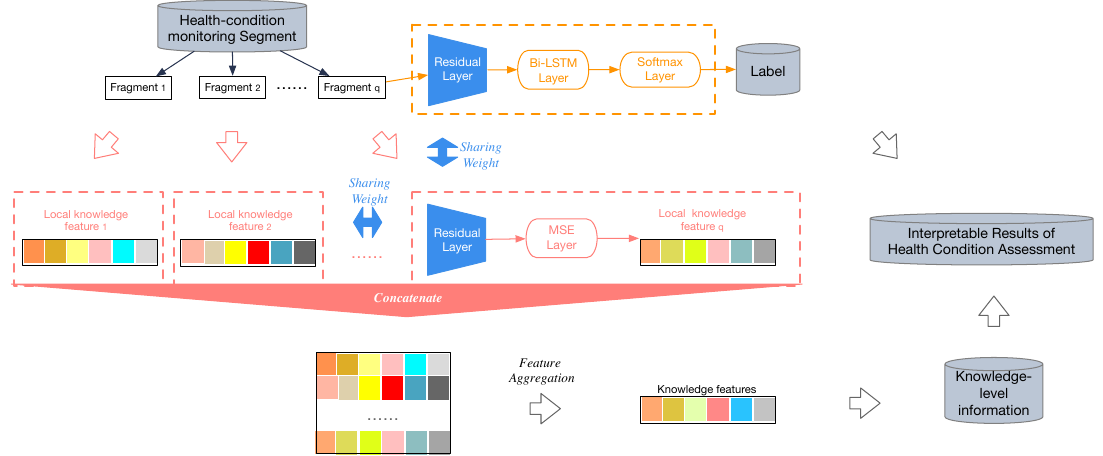
Figure 5. The architecture of a knowledge-directed interpretation